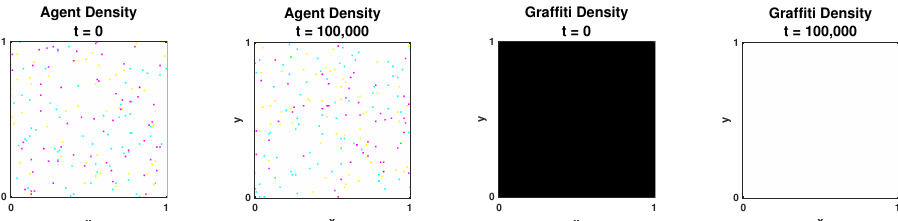
Figure 1. Agent ( left two ) and graffiti ( right two ) densities’ temporal evolution for a well-mixed state. Here we have N 1 = N 2 = N 3 = 50,000, with λ = γ = 0.5, β = 5 × 10 − 6 , δ t = 1 and the lattice size is 100 × 100. Note that the initial graffiti lattice appears black because it is empty. The final graffiti lattice appears white because all sites have (almost) the same graffiti densities from all three gangs. It is clear from this figure that the agents remain well mixed over time.